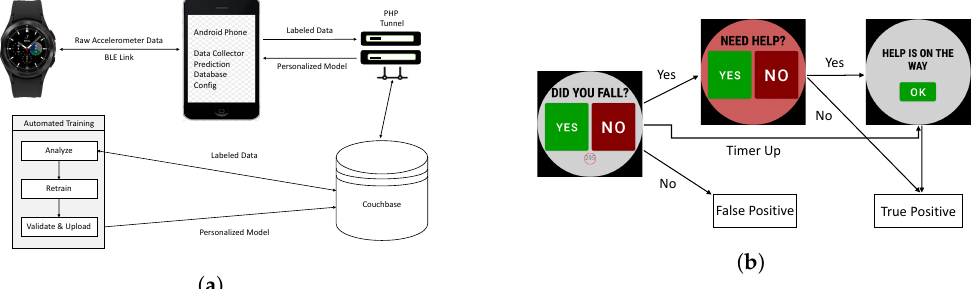
Figure 2. Architecture of SmartFall system. ( a ) An overview of the SmartFall system. ( b ) Watch’s user interface display after a fall is